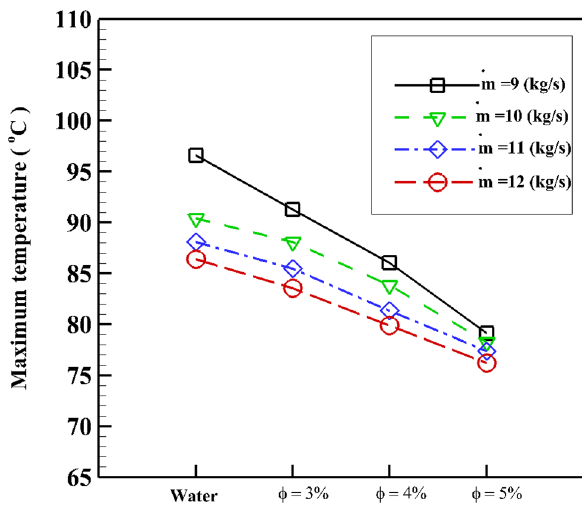
Fig. 17 Difference between maximum and averaged temperature on WCP hot-side